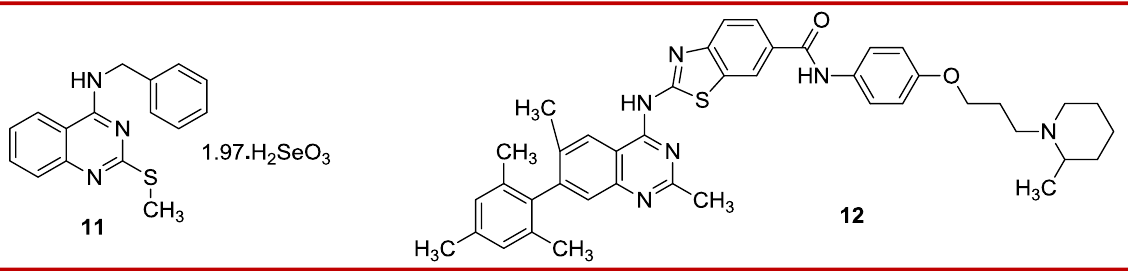
Figure 6: SAR study showing the significant role of 4-anilinoquinazoline as antitumor